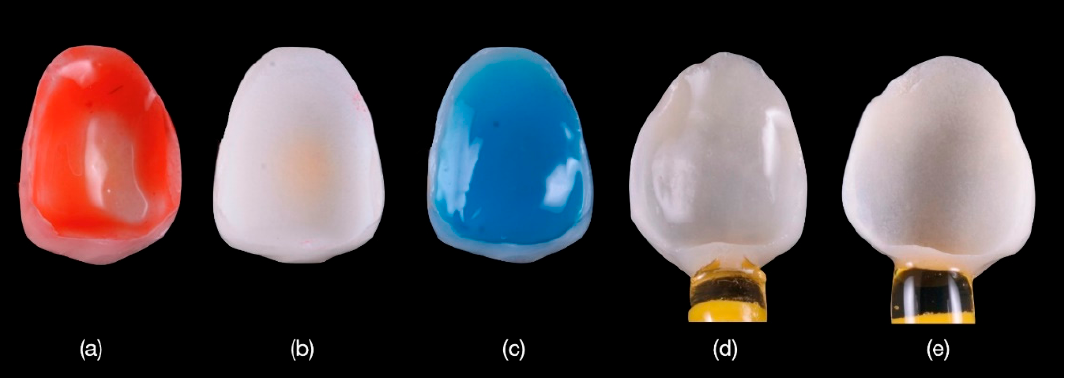
Figure 8. ( a ) Conditioning the feldspathic veneers with hydrofluoric acid applied for 60 s then ( b ) washed and rinsed with water and dried; ( c ) crystalline debris precipitate at the ceramic surface was removed with 36% orthophosphoric acid; ( d ) the etched surfaces were silanized with Monobond Plus for 60 s; and ( e ) dried to obtain a monolayer of